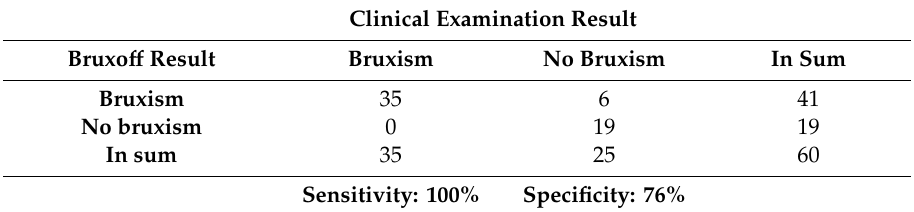
Table 12. Comparison between the clinical examination result and Bruxo ff result in diagnosing